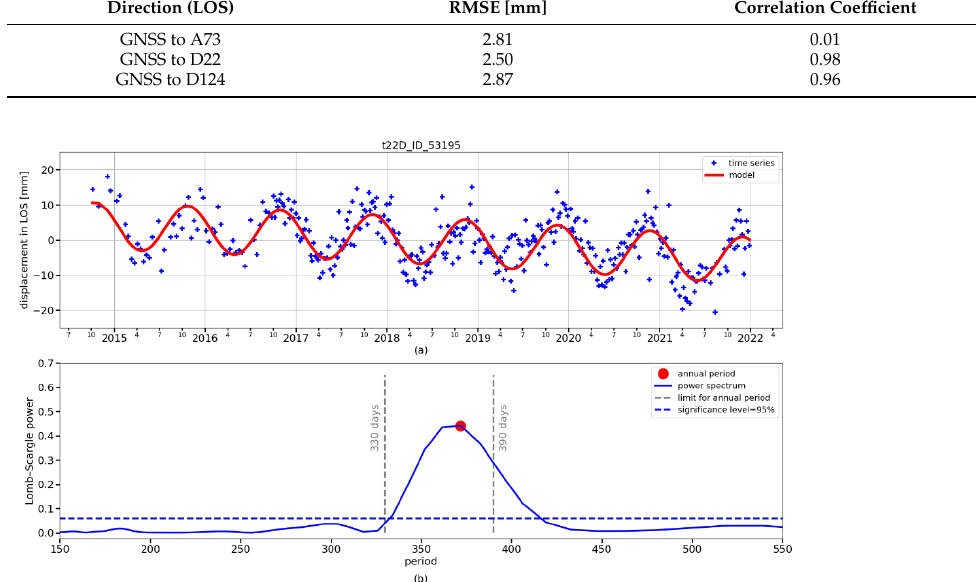
Figure 14. Position of PS points from the InSAR processing near the GNSS TVRN station (green cross). Points from ascending track A73 are shown in yellow, points from descending track D124 in blue, and descending track D22 in red. 3.3. Comparison of E – W displacement from PSInSAR and GNSS As can be seen from Table 1, the modelled data had to be truncated in the range from 14 October 2014 to 18 December 2021 (which corresponds to the most extended time series